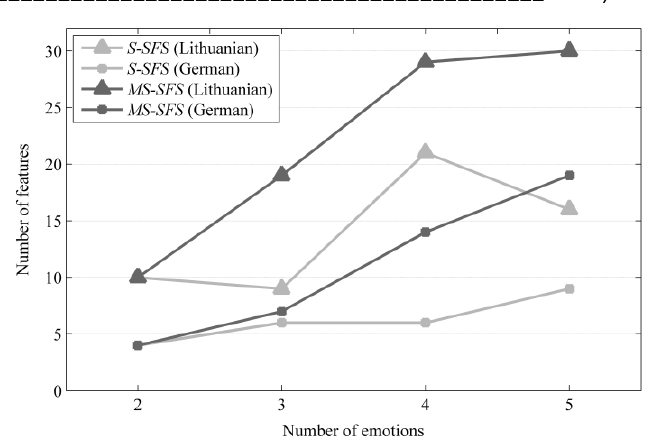
Fig. 4. Dependence of the feature set size on the number of analyzed emotions. R